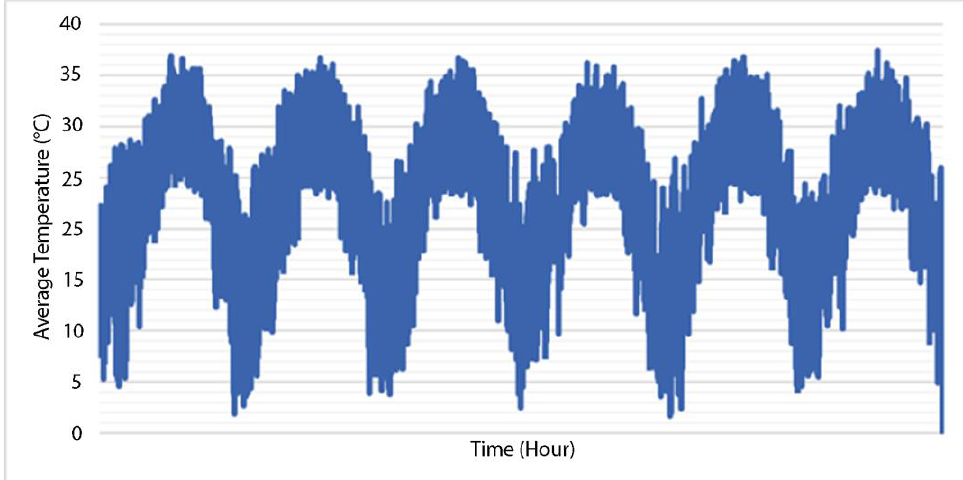
Figure 7. Hourly temperature, 2010 – 2015.